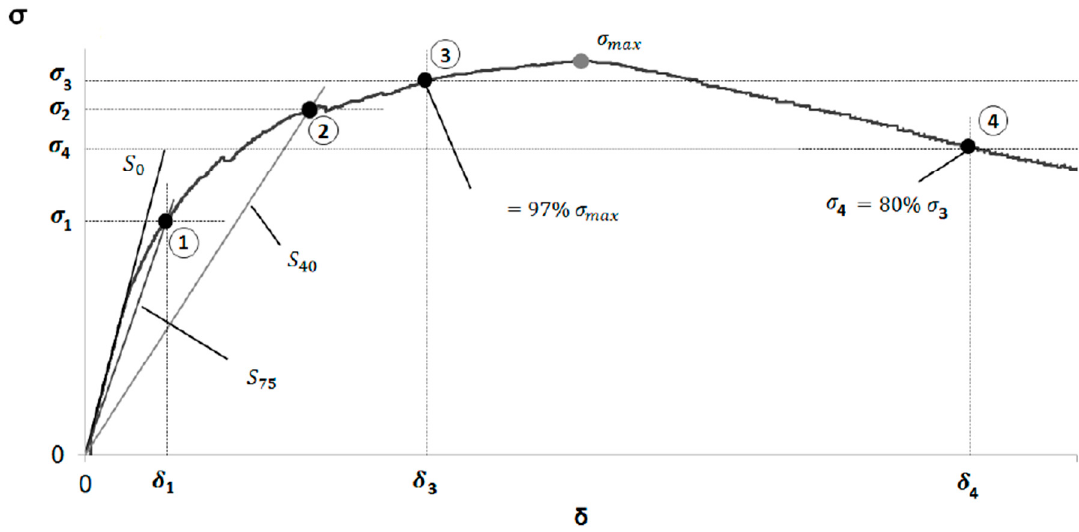
Figure 8. Stress–strain curves and key Figure 8. Stress – strain curves and key points.